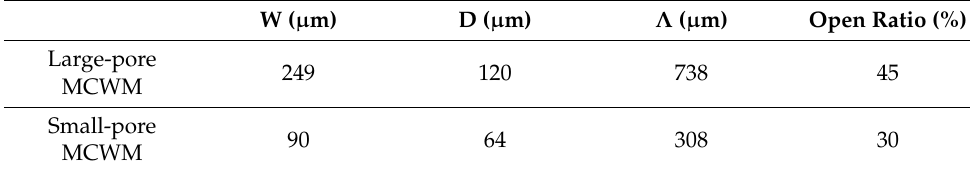
Figure 1. ( a ) Unit structure of MCWM (a 3D-view drawing); ( b ) macroscopic and microscopic photographs of a PET mesh; ( c ) side views of a schematic drawing and a microscopic photograph of an MCWM unit structure; ( d ) configuration of the reading unit (i.e., the THz-TDS system) for a MCWM Table 1. Dimensions of two MCWMs in experiments.